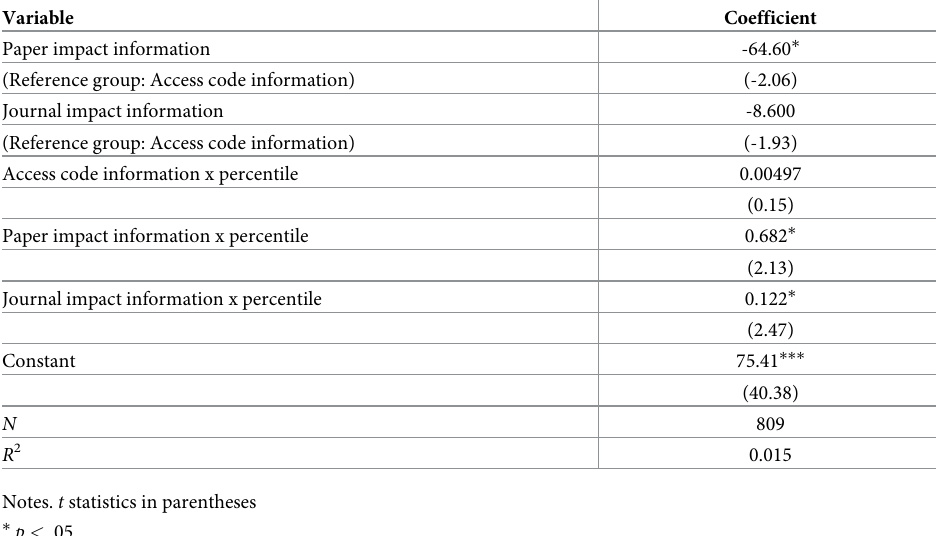
Table 5. Regression of quality assessment on information percentile